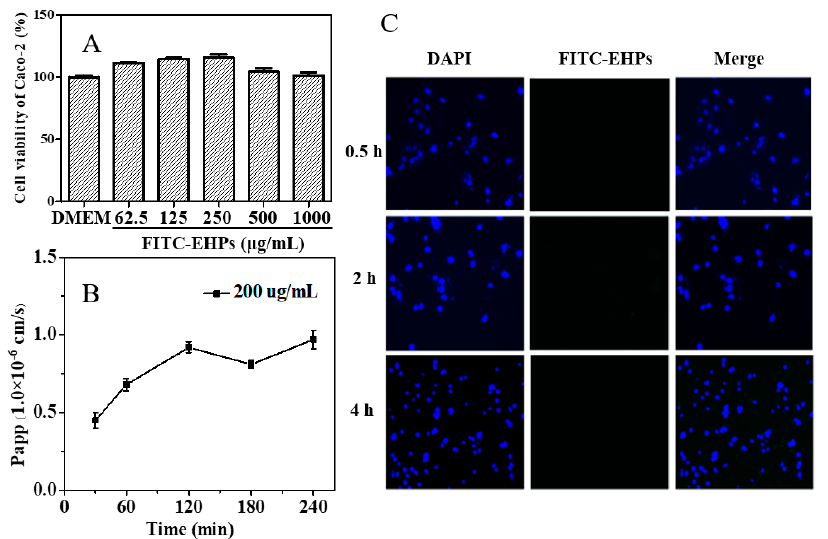
Figure 3. Toxicity of FITC-EHPs on Caco-2 cells ( A ), Papp value ( B ), and uptake of FITC-EHPs in Caoco-2 cells ( C ).